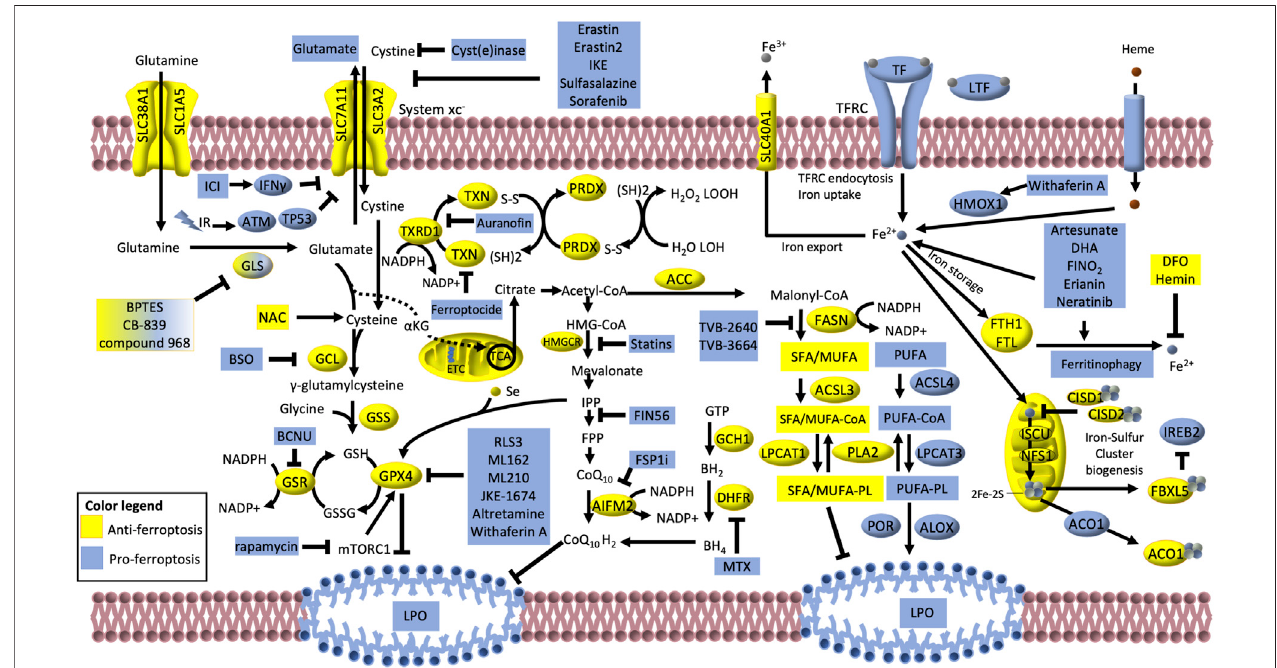
FIGURE5| Iron-dependent lipidperoxidation isthe hallmark offerroptosis. Thecystine/glutamate transporter,consisting ofthe SLC3A2 and SLC7A11(alias xCT) subunits, (collectively known as system xc − ) imports cystine in exchange for glutamate. Glutamate is produced via glutaminase (GLS) -dependent glutaminolysis of glutamine.Ifnotexported,glutamatecaneitherbeconvertedinto α -ketoglutarateandentertheTCAcycleorparticipatetoglutathione(GSH)synthesisviatwosequential reactions catalyzed by glutamate – cysteine ligase (GCL) and glutathione synthetase (GSS). Glutathione peroxidase GPX4 uses GSH to buffer lipid peroxidation (LPO) and protect cells from ferroptosis. The oxidized glutathione (GSSG) is then reduced to GSH via glutathione – disul fi de reductase (GSR) using NADPH as electron donor. GSH is a tripeptide antioxidant derived from glutamate, glycine and cysteine, which is turn produced by the reduction of cystine catalyzed by the thioredoxin reductase 1 (TXRD1). Along with the GPX4/GSH system, the TXRD/TXN and the peroxiredoxin (PRDX) systems can convert the phospholipid hydroperoxides (H 2 O 2 LOOH) to alcohols and water (H 2 O LOH). The AIFM2 (FSP1) – CoQ10 can also counteract LPO and ferroptosis. Moreover, the mevalonate pathway, can indirectly inhibit ferroptosis giving rise to CoQ10 and producing the isopentenyl diphosphate (IPP) that is the precursor for the selenium (Se)-containing GPX4. Also, the GCH1 – dihydrofolate reductase (DHFR) system protects lipid membranes from autoxidation catalyzing the biosynthesis of the tetrahydrobiopterin (BH4). Many proteins involved in iron transport, storage and metabolism are key determinants of ferroptosis execution: these include transferrin (TF), lactotranferrin (LTF), transferrin receptor (TFRC), solute carrier family 40 member 1 (SLC40A1), heme oxygenase (HMOX1) and ferritin components (FTH1 and FTL). Also, the mitochondrial proteins cysteine desulfurase (NFS1) and iron – sulfur cluster assembly (ISCU) can reduce the availability of iron by sequestering Fe 2+ for the biosynthesis of iron – sulfur clusters (2Fe – 2S). The iron-regulatory proteins CISD1, CISD2, ACO1 and FBXL5/IREB2 usually negatively regulate ferroptosis. However, under low 2Fe – 2S, ACO1 and IREB2 can translationally regulate iron metabolism-related proteins (such as TFRC, SLC11A2, SLC40A1, FTH1 and FTL), thus facilitating ferroptosis. Lipid synthesis and metabolismalsoplayacentralroleinferroptosis, byregulatingtheavailabilityofsubstratesforLPO.Acetyl-CoAcarboxylase(ACC)/FASNaxismediates thesynthesisof fatty acids (FA), mainly saturated (SFA) and monounsaturated (MUFA), which have low susceptibility to LPO. SFA/MUFA are conjugated to CoA by the long-chain fatty acid – CoA ligase 3 (ACSL3) prior to be incorporated into membrane phospholipids (PL) via the lysophosphatidylcholine acyltransferase 1 (LPCAT1). On the other hand, Long-chain fatty acid – CoA ligase 4 (ACSL4) and lysophosphatidylcholine acyltransferase 3 (LPCAT3) promote the incorporation of exogenous or lipophagy-derived polyunsaturated FA (PUFA) into PL forming PUFA-PL, which are susceptible to free radical oxidation mediated by lipoxygenases (ALOX) and cytochrome P450 oxidoreductases (POR). Phosholipase A2 (PLA2) can partially counteract this process by cutting out the oxidized FA chains of PUFA-PL. Compounds, proteins,